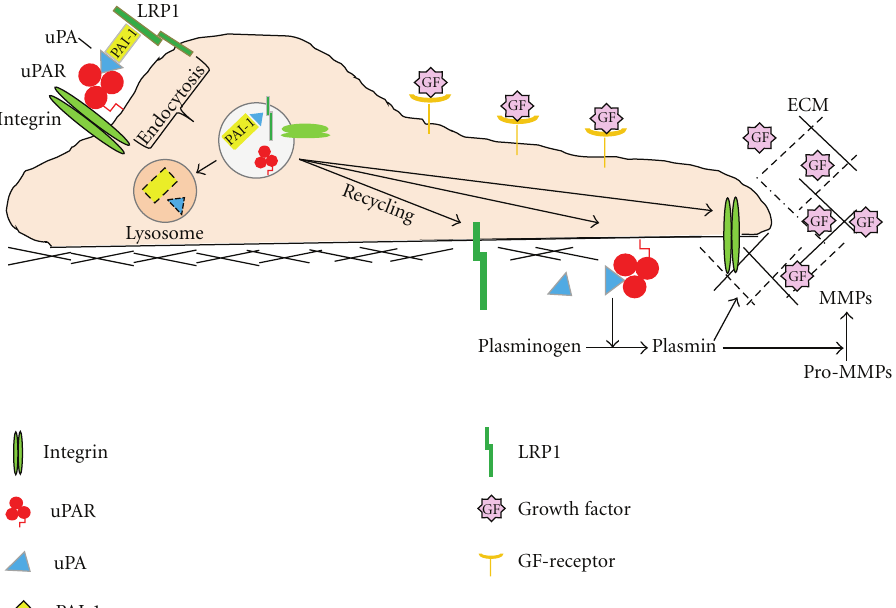
Figure 3: PAI-1 modulates cell migration by regulating ECM proteolysis. Physiological control of pericellular proteolysis occurs primarily through the regulation of plasminogen activation at the cell surface, which, in turn contributes to downstream MMP activity. Focal proteolysis disrupts ECM architecture, breaking cell-matrix interactions with receptors, such as integrins, and releasing bioactive fragments of extracellular matrix molecules, as well as growth factors that stimulate migratory behavior. PAI-1, through its ability to inhibit uPA- dependent activation of plasmin, titers this process maintaining the sca ff olding necessary to facilitate cell migration. PAI-1: plasminogen activator inhibitor type-1, uPA: urokinase-type plasminogen activator, uPAR: uPA receptor, MMP: matrix metalloproteinase, GF: growth factor, LRP1: low-density lipoprotein receptor-related